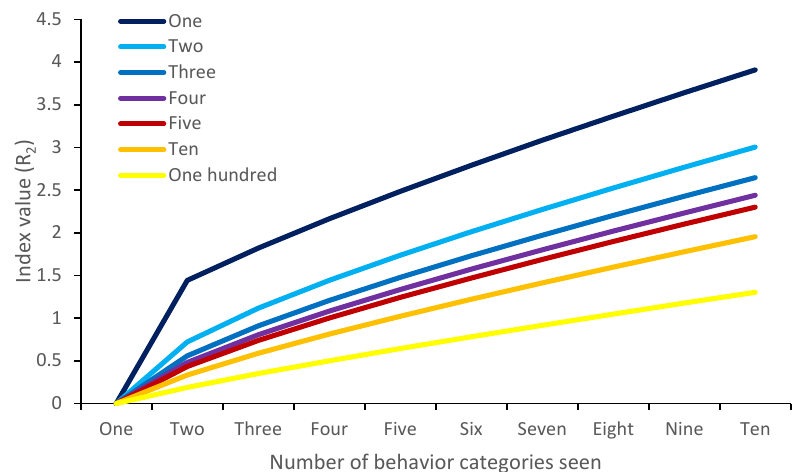
Figure 6. Margalef index values when each behavior is seen equally at a rate of one, two, three, four, five, ten or one hundred times in an observation period. The Margalef index does not take into account evenness of observations.